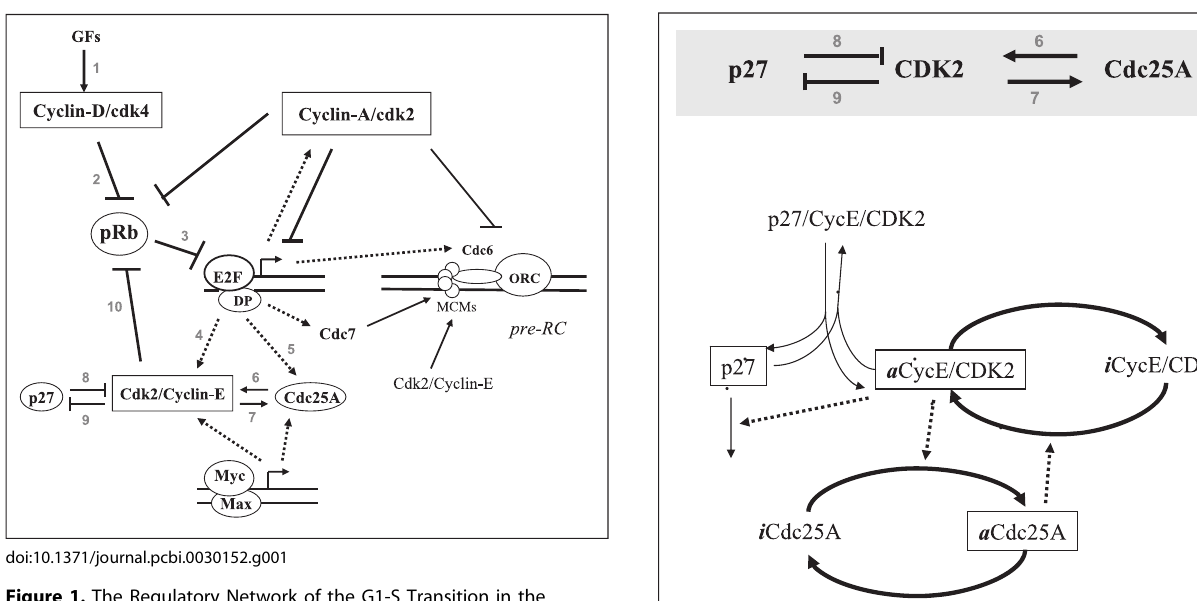
hammerhead means ‘‘ inhibits ’’ ).